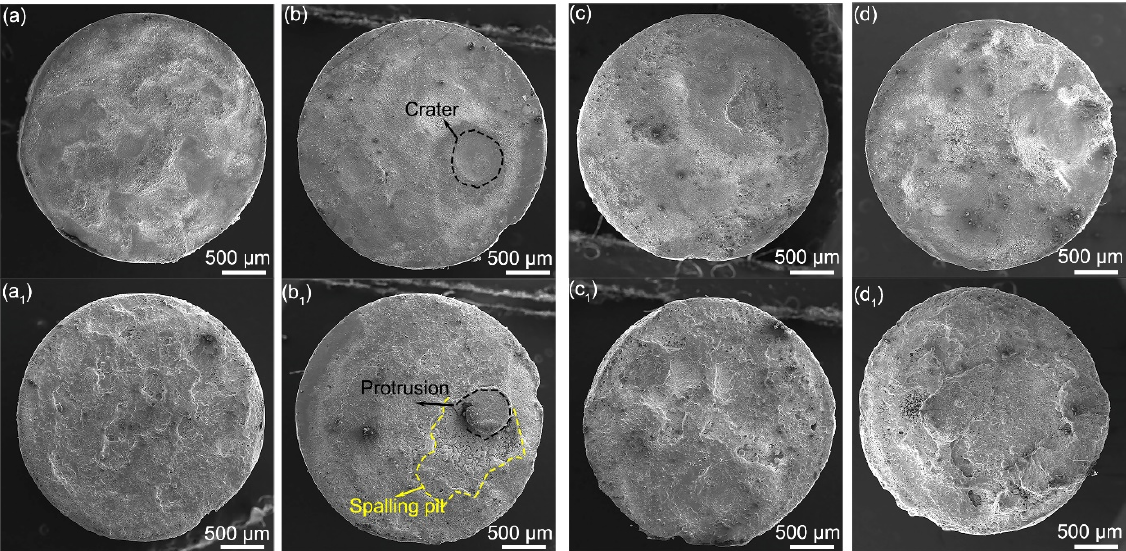
Figure 6. The morphologies of cathode ( a – d ) and anode ( a 1 – d 1 ) after 10 5 cycle tests. The mean size of Y 2 O 3 used: ( a , a 1 ) 243 nm, ( b , b 1 ) 387 nm, ( c , c 1 ) 792 nm, ( d , d 1 ) 980 nm.